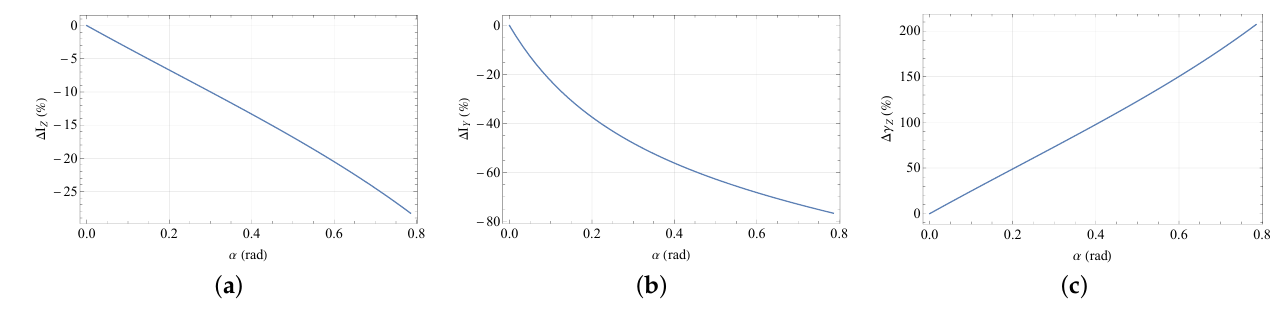
Figure 13. Variation of relevant suspension parameters with respect to the inclination of the lower arm of a McPherson suspension: ( a ) vertical installation ratio, I Z ; ( b ) lateral installation ratio, I Y ; ( c ) camber gain, γ Z .